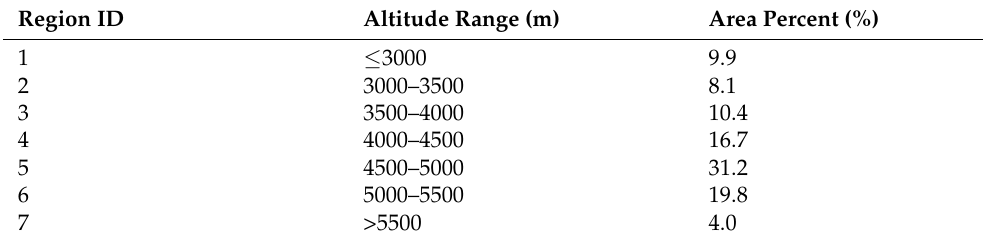
Table 2. The altitude regions over the whole Qinghai–Tibetan Plateau.